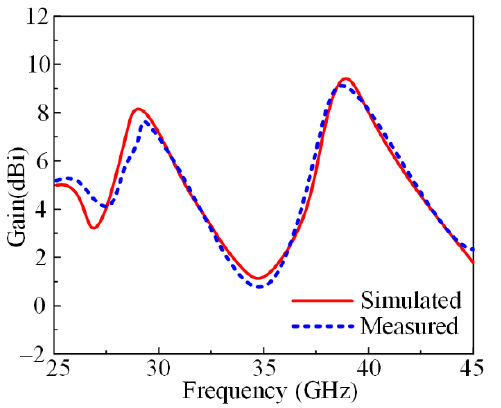
Figure 4. Measured and simulated gain of proposed dual-band antenna.